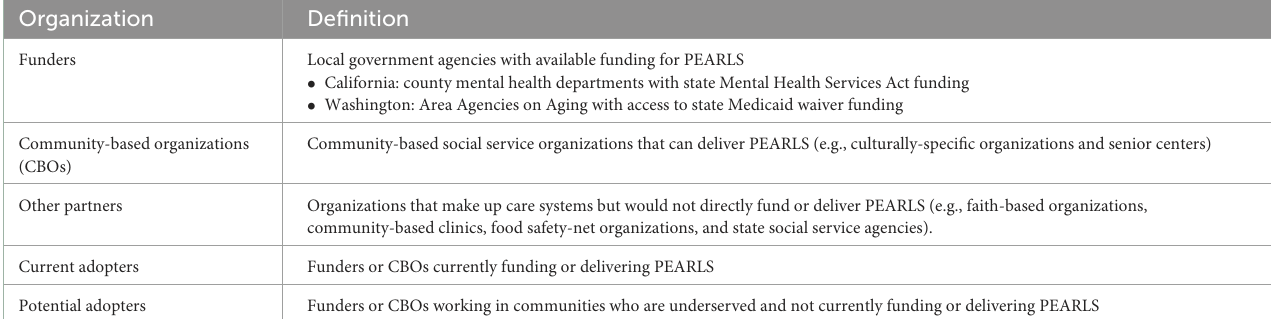
TABLE 1 Defining organizations for interview sampling.